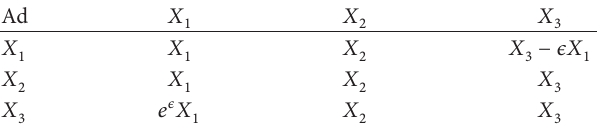
Table 2: Adjoint table of the Lie algebra of (2). Ad 𝑋 1 𝑋 2